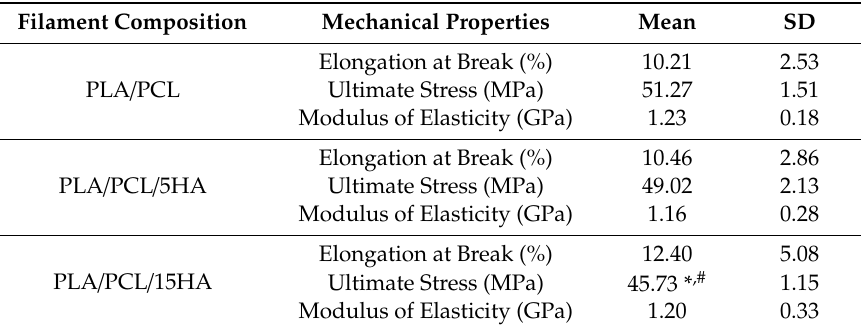
Table 4. Summary of the filament tensile testing.